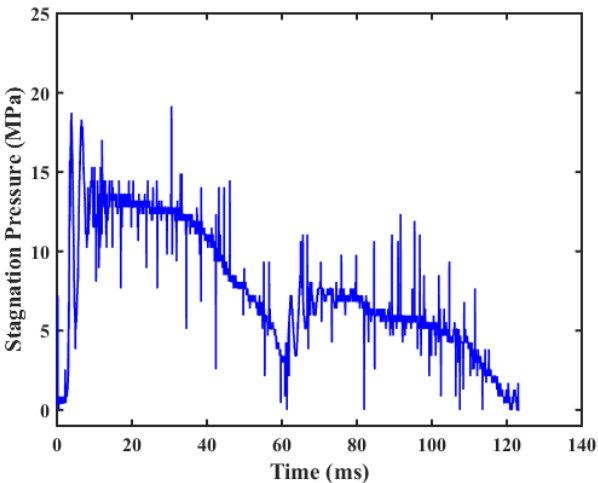
Figure 15. The stagnation pressure evolution for a two-pulse injection profile.